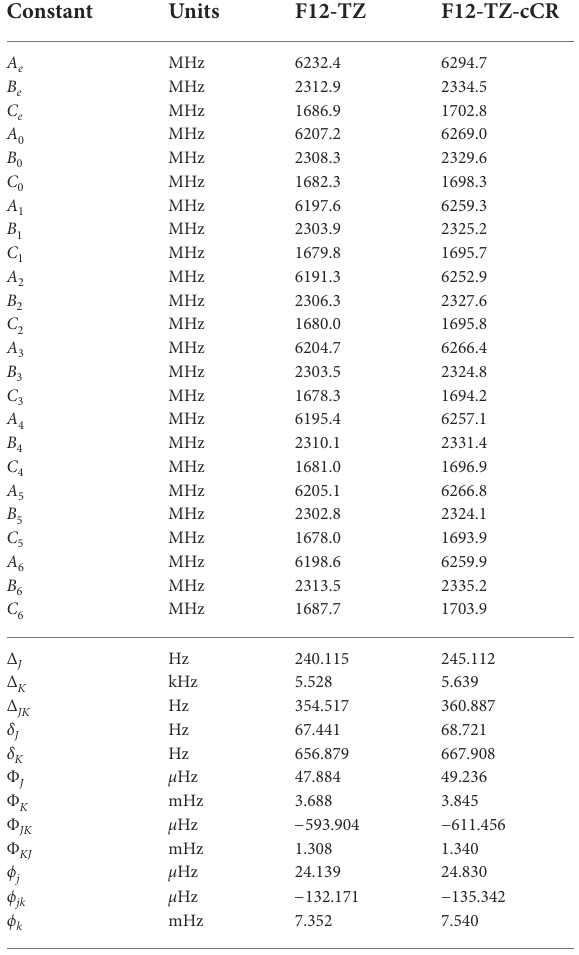
TABLE 10 Equilibrium ( e ), vibrationally-averaged ( 0 ), and singly-vibrationally excited ( n >0 ) principal rotational constants, quartic ( Δ / δ ) and sextic ( Φ / ϕ ) distortion constants, principal rotational constants, and quartic for r -Si 4